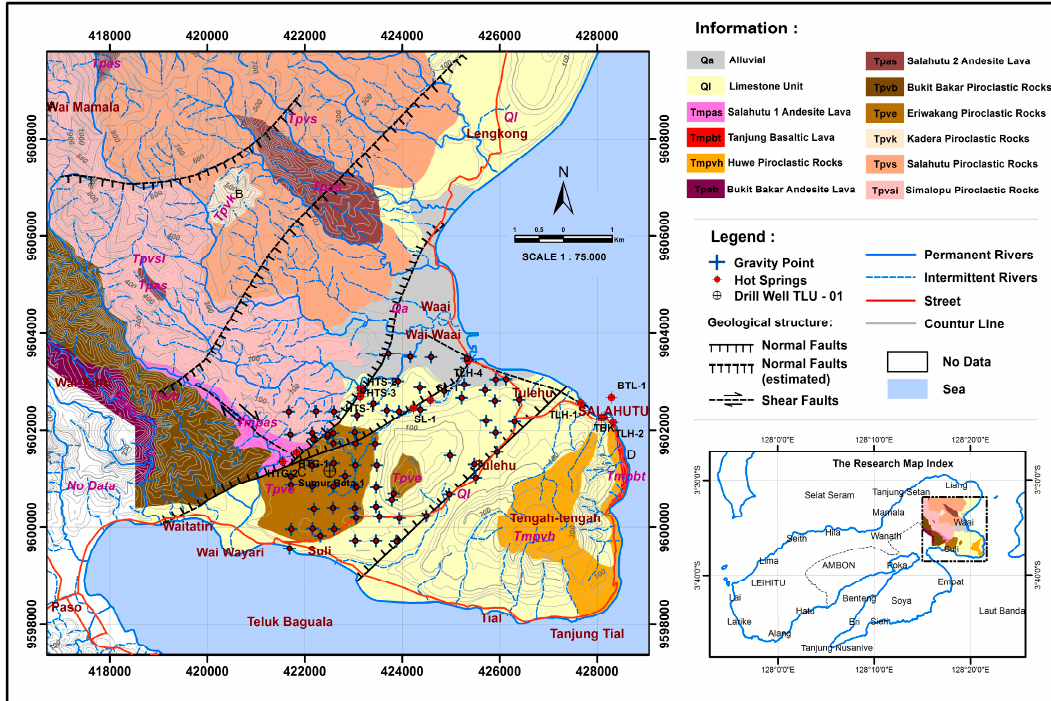
Figure 1. The geological map of Suli and Tulehu geothermal areas, Ambon Island, Eastern Indonesia (This map was modified from [1,3]).